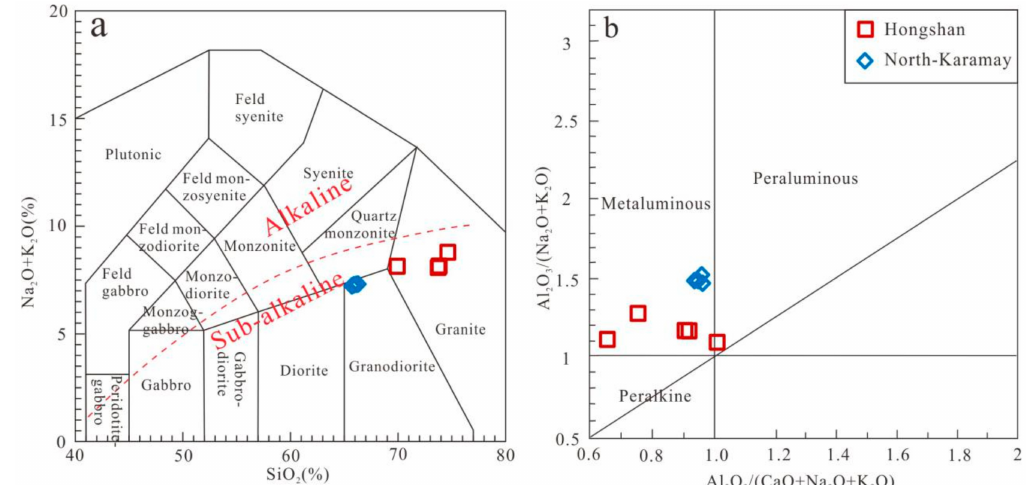
Figure 6. Major and trace element diagrams of the granitoids: ( a ) Na 2 O + K 2 O vs. SiO 2 diagram (after Middlemost [81]); ( b ) Al 2 O 3 / (Na 2 O + K 2 O) vs. Al 2 O 3 / (CaO + Na 2 O + K 2 O) diagram (after Maniar and Piccoli.